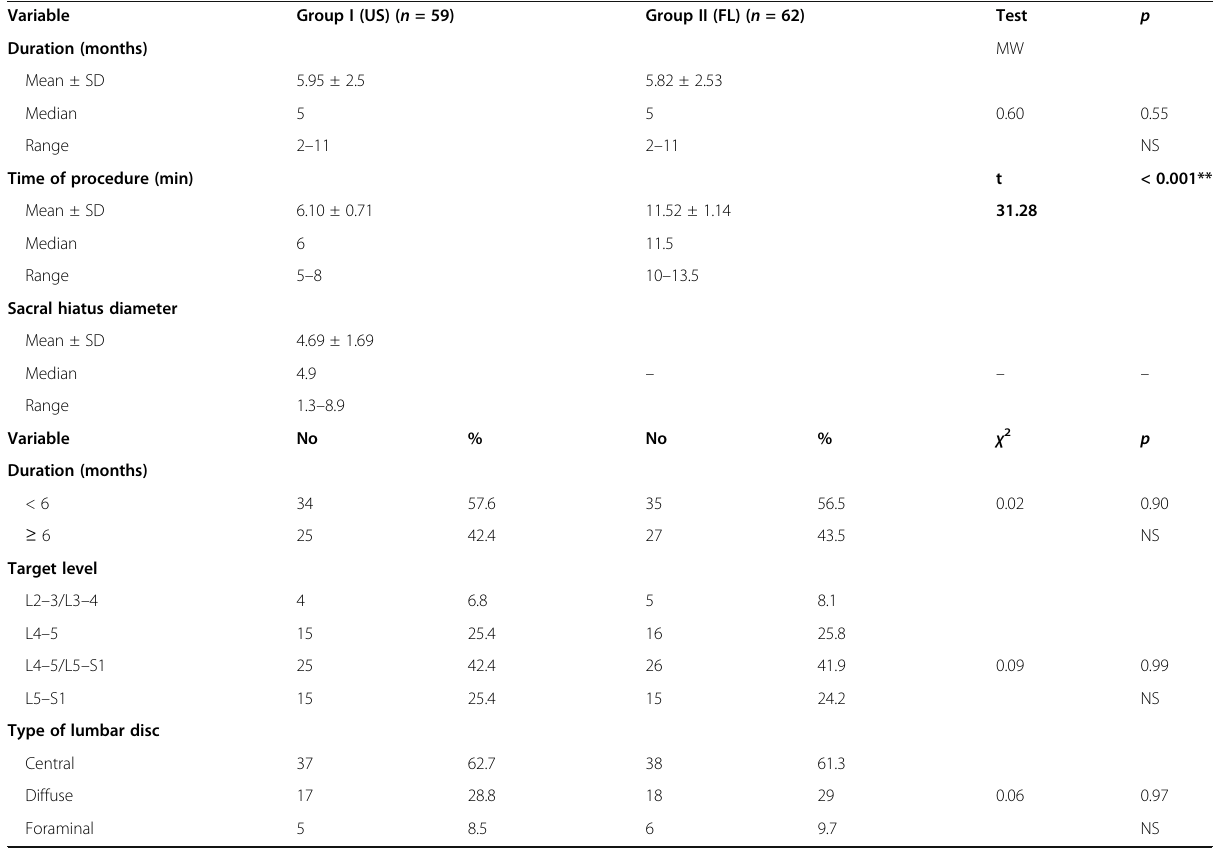
Table 2 Duration of disease, time of procedure, target level, and type of LDP among the two groups and SH diameter in the US